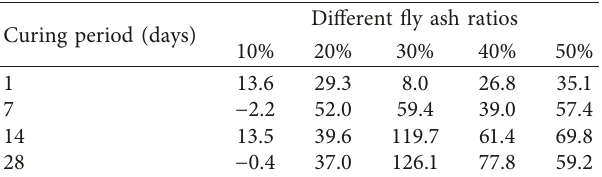
Figure 11: Effect of fiber content on stress-strain curve of specimen after 28 curing of ∗